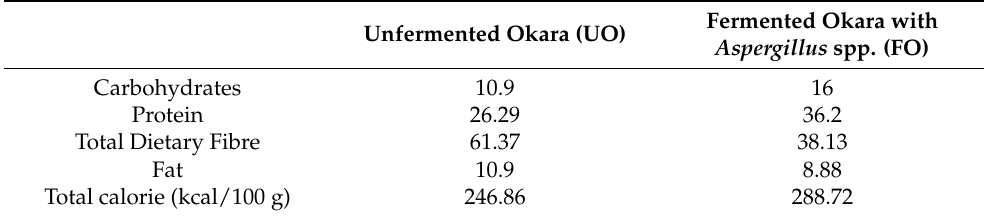
Table 4. The macronutrient composition of unfermented okara and okara fermented with Aspergillus spp. (g/100